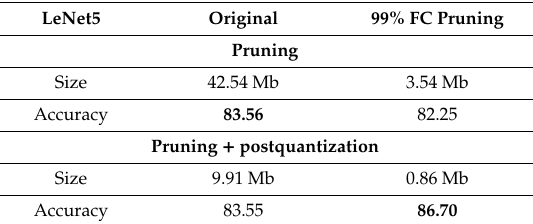
Table 8. Comparison in terms of size and accuracy before and after compression of LeNt5 FC-layer on the plant seedlings